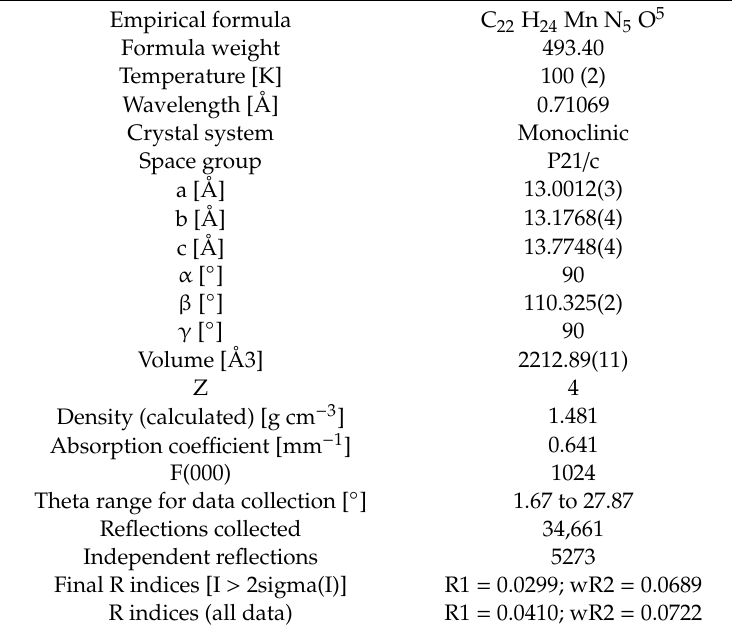
Table 2. Crystal data and structure refinement for